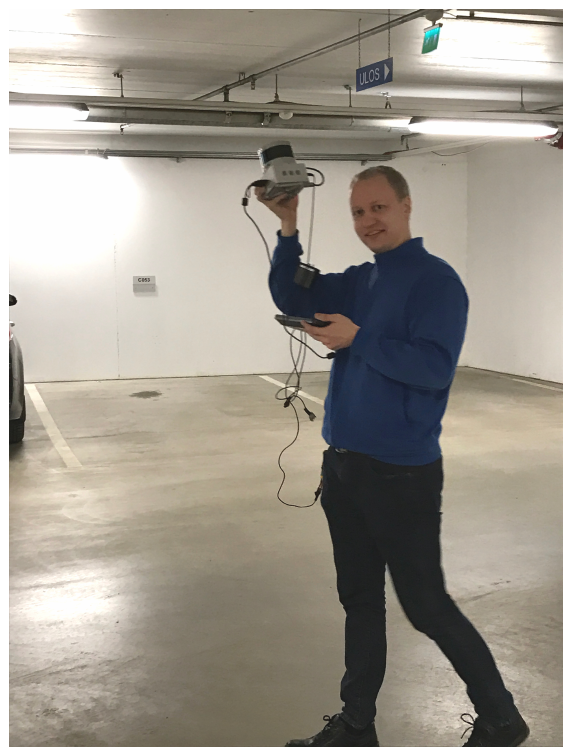
Figure 6. Data acquisition using Kaarta